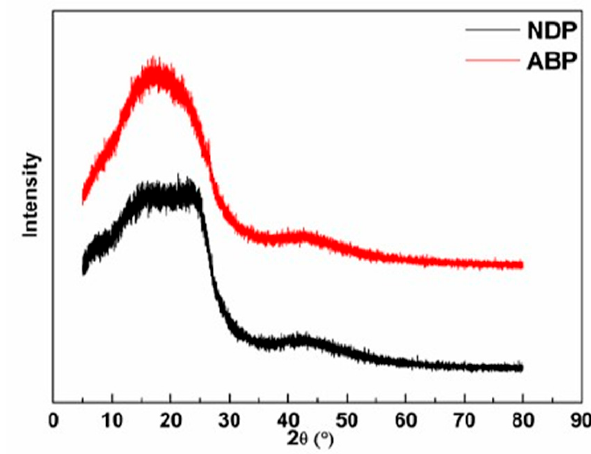
Figure 4. X-ray diffractograms of the NDP and the ABP.